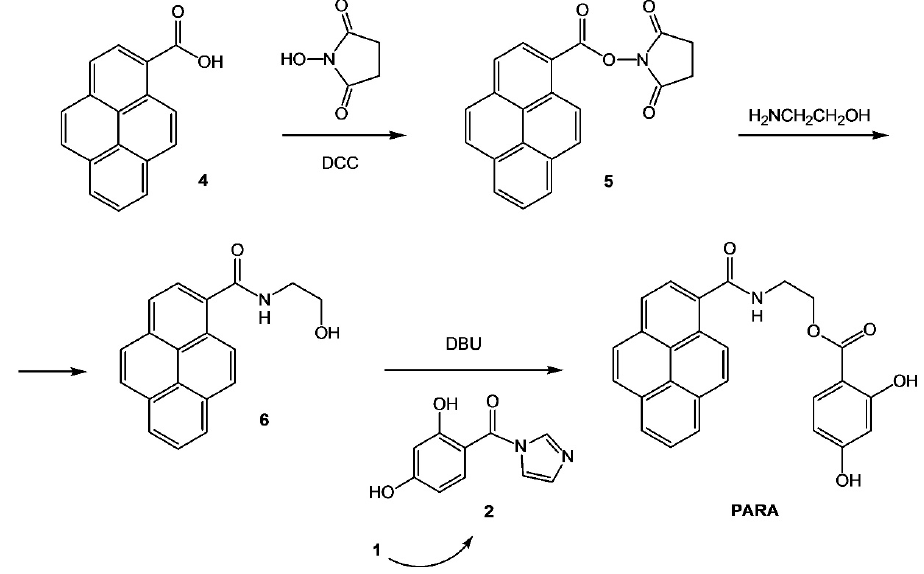
Figure 1. Synthesis of the fluorescent tracer.